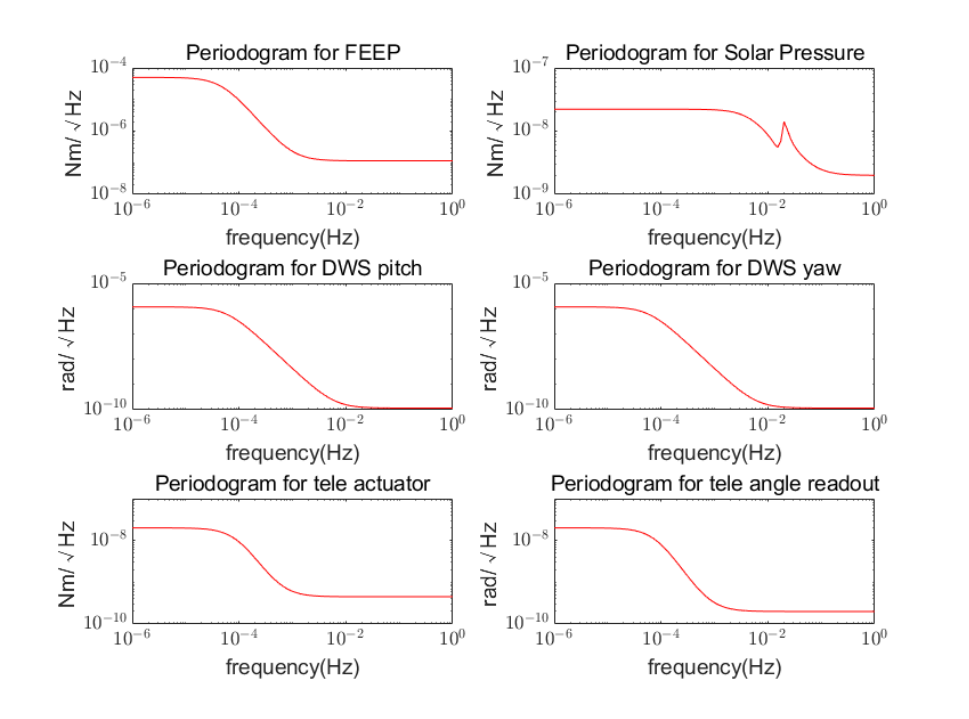
Figure 4. Noise shape functions, including those for the spacecraft’s FEEP micro-thrust actuator, solar pressure, spacecraft attitude measurement for the DWS pitch and yaw axis, telescope attitude actuator, and telescope angle readout.